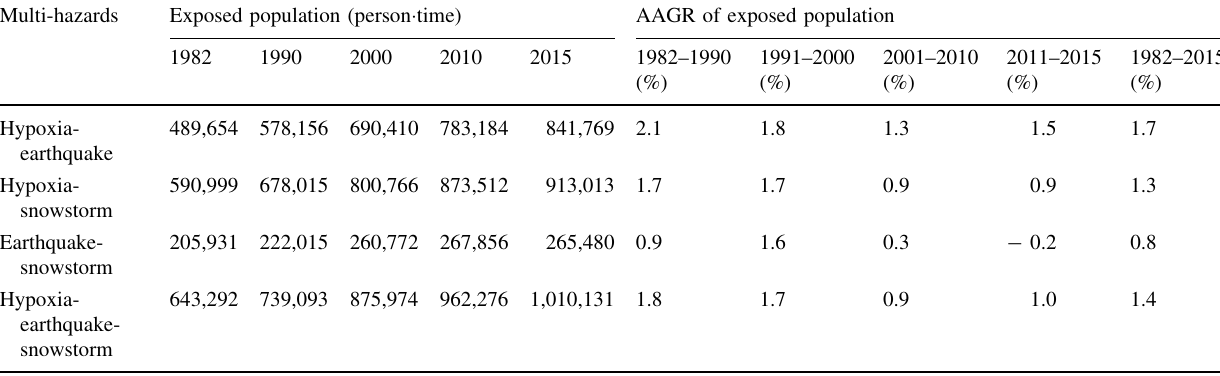
Table 5 Person (cid:2) time and average annual growth rate (AAGR) of multi-hazard exposure in Tibet, 1982–2015 Multi-hazards